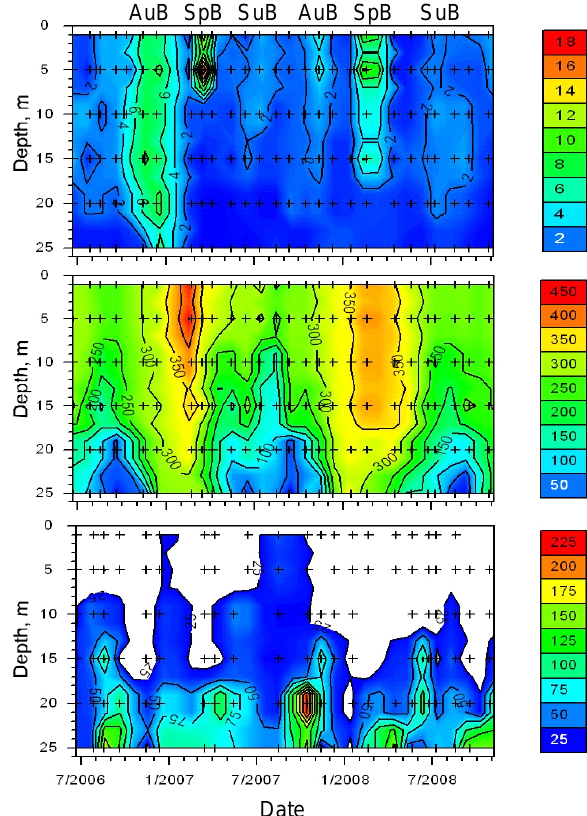
Fig. 2. Time series of chlorophyll a in µgL − 1 (upper panel), [O 2 ] in µmolL − 1 (central panel) and [CH 4 ] in nmolL − 1 (lower panel) at the Boknis Eck time series station. Crosses mark the available measurements. Phytoplankton blooms are indicated: AuB, autumn bloom; SpB, spring bloom; SuB, summer bloom. On the x-axis the date is given as m/yyyy (e.g., 1/2007 stands for 1 January